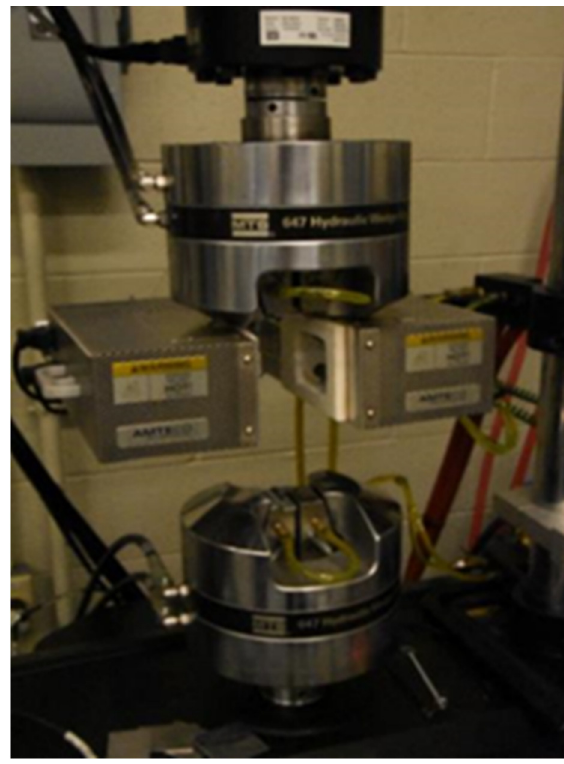
Figure 5. MTS thermo-mechanical fatigue (TMF) test rig.